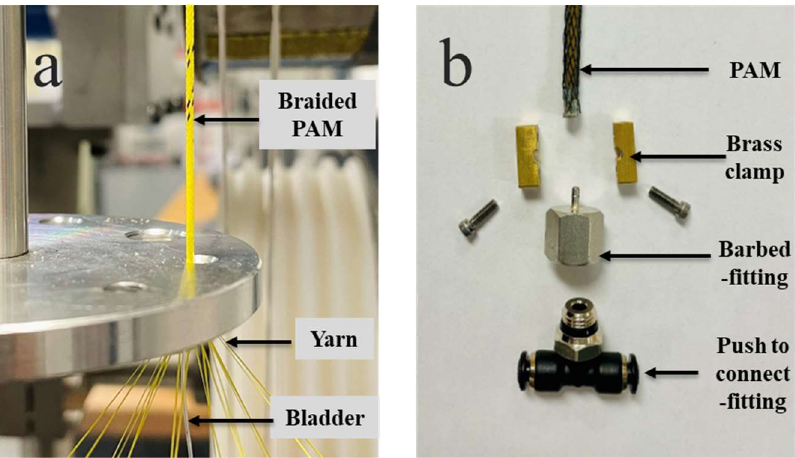
Figure 3. Fabrication of PAM. ( a ) Braiding PAM using a vertical braiding machine and ( b ) end fittings assembly for PAM.